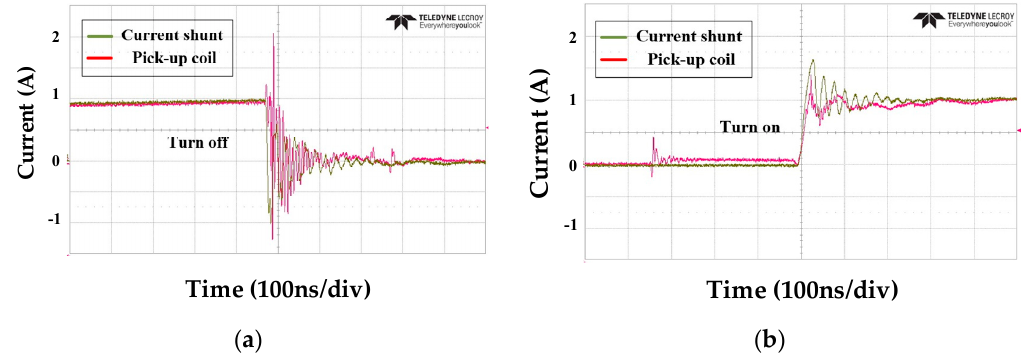
Figure 14. Measured pick-up coil sensor output following switch behavior for a DC link voltage of 250 V: ( a ) switch turn-off; ( b ) switch turn-on.